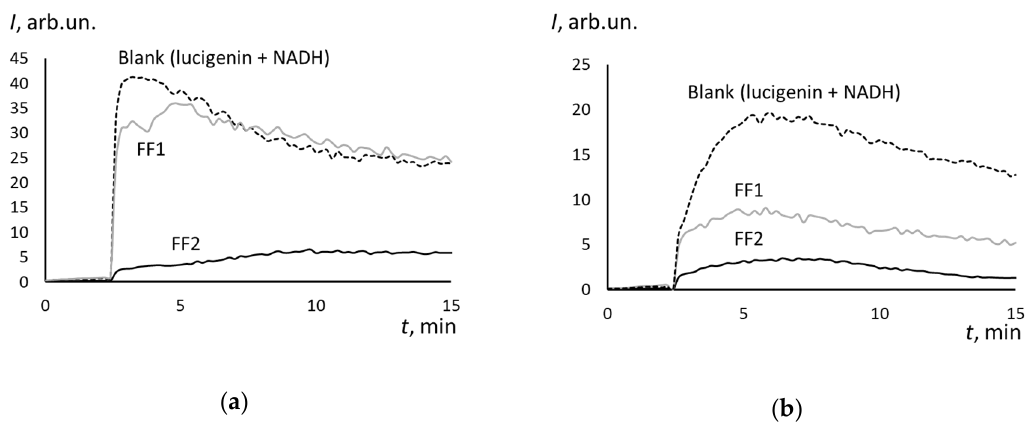
Figure 8. Effect of ( a ) FF1 (0.05 mM) and FF2 (0.30 mM) and ( b ) FF1 (0.30 mM) and FF2 (0.30 mM) on lucigenin-enhanced (0.40 mM) chemiluminescence in the presence of NADH (0.8 mM).